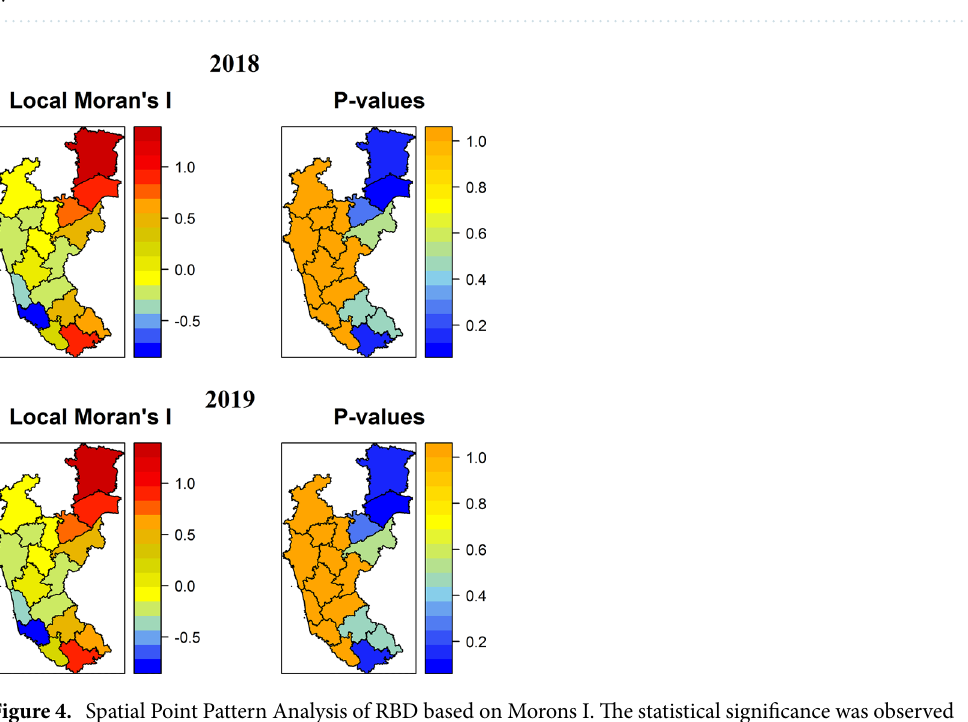
Figure 3. ( A ) Bar graph repressing the severity of rice blast disease (RBD) in different districts of Karnataka during 2018 and 2019. ( B ) Clustering of districts based on the severity of RBD in different districts of Karnataka by hclust method.